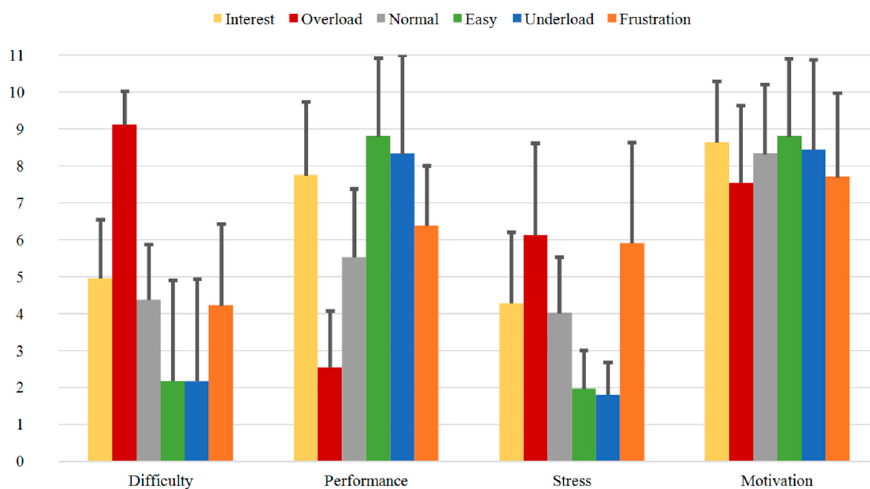
Figure 13. Direct Questions of Group B1 for all the sequences with mean values.